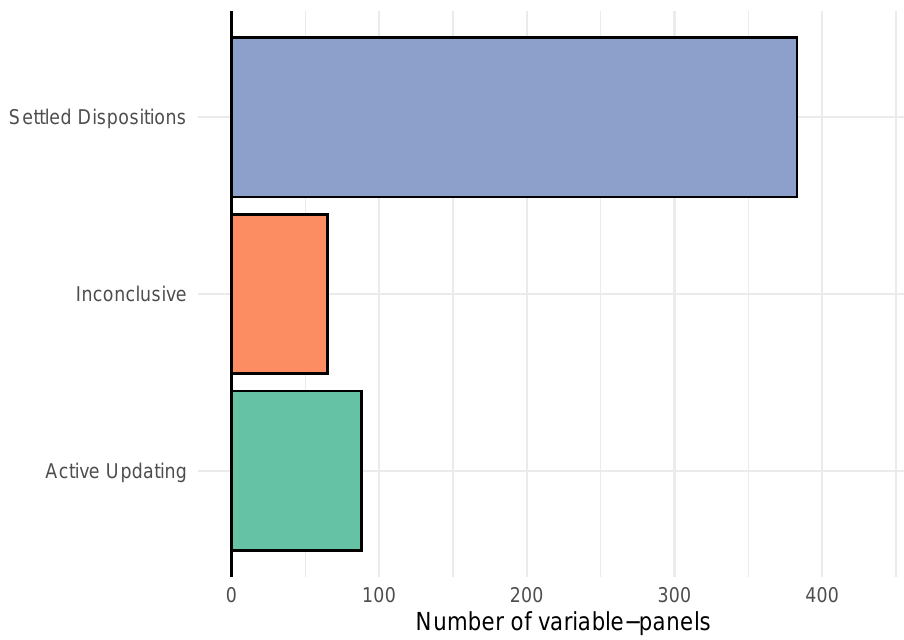
Figure 3: Count of preferred models, determined through BIC comparisons. Com- parisons where BIC difference between best-fitting SDM and best-fitting AUM was less than two were classified as